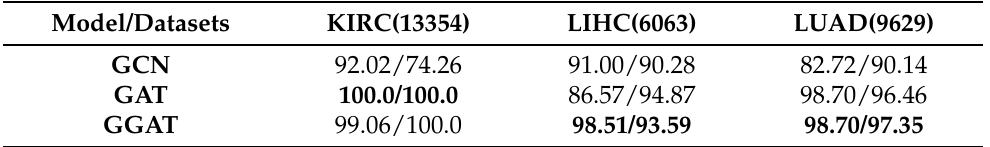
Table 8. Sensitivity vs. Specificity (TPR vs. TNR, %) of three Graph Convolution Models Under Original Feature